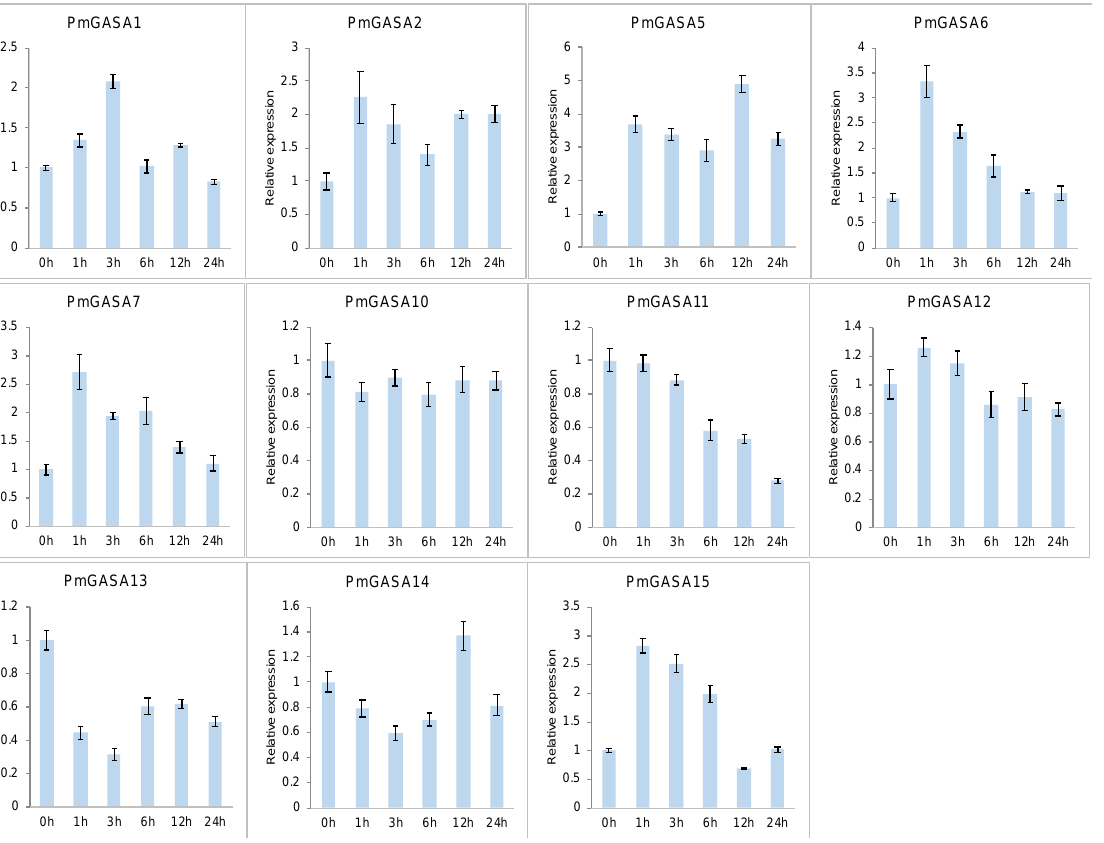
Figure 7. Relative expression levels of PmGASAs in leaves over two days, after gibberellin treatment. Error bars represent the standard deviations assessed from three technical replicates.